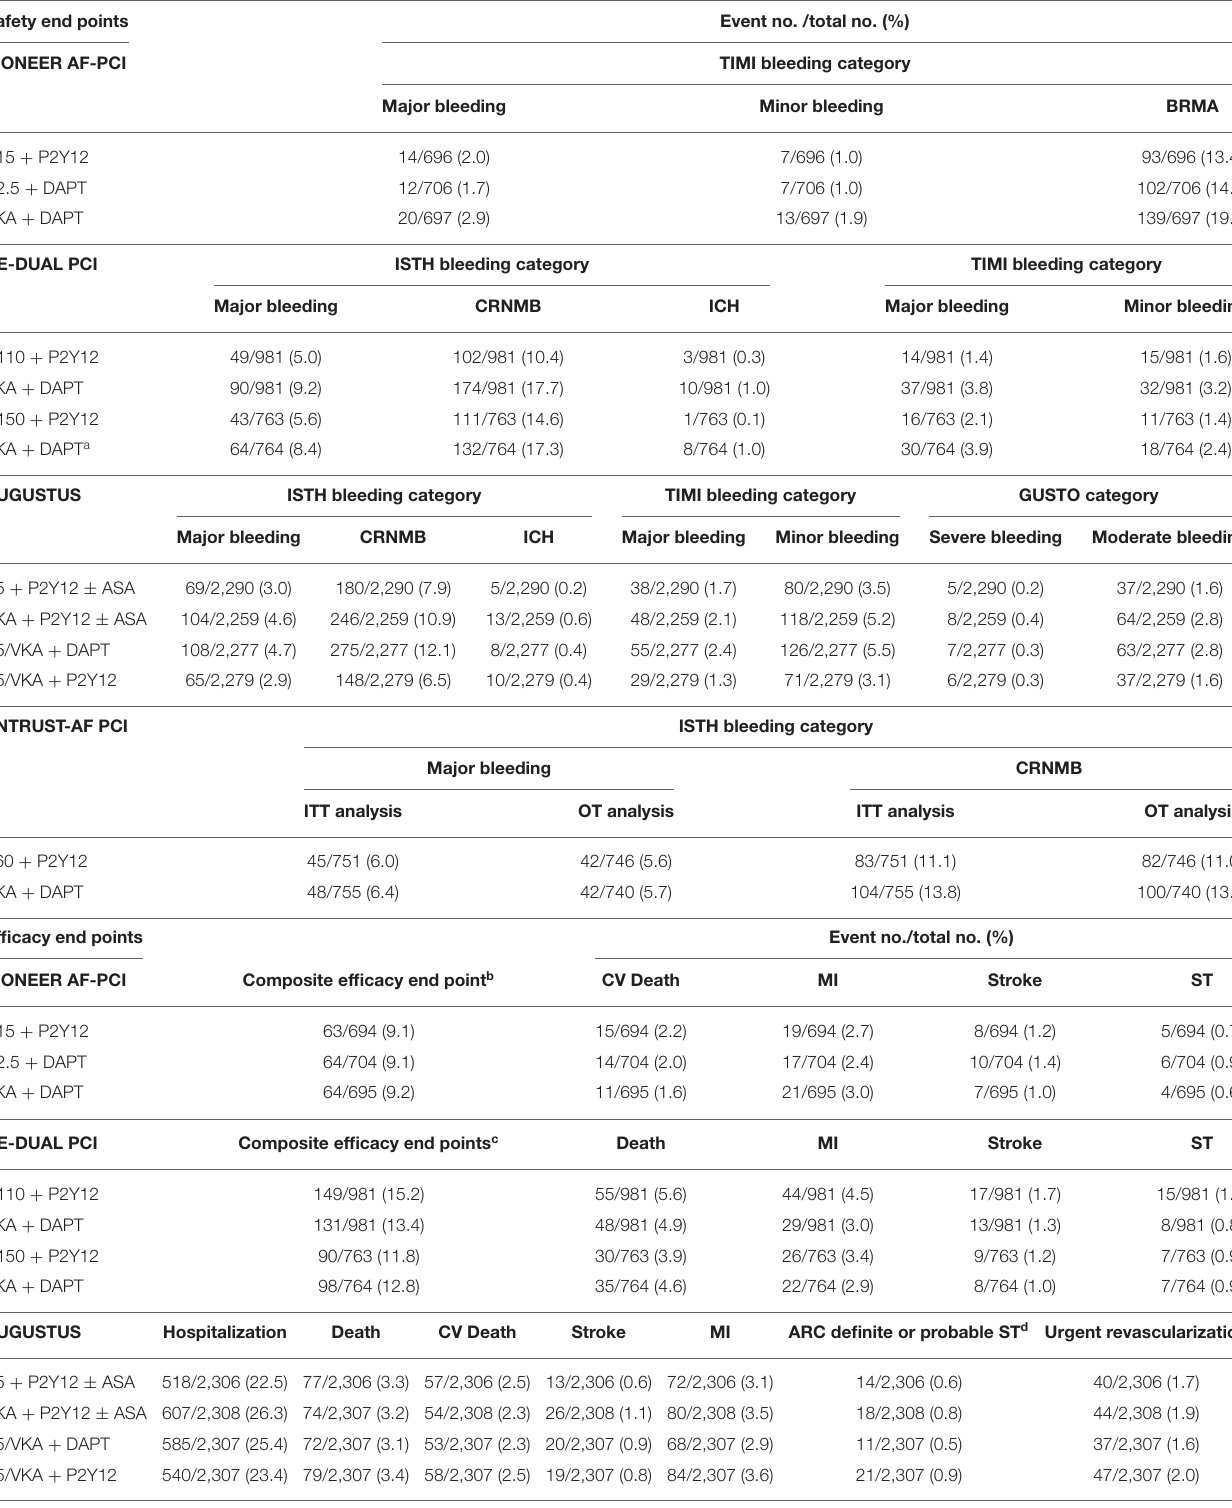
TABLE 1 | Clinical end point presentations with NOAC-based antithrombotic therapy regimens for AF patients undergoing PCI or with ACS: PIONEER AF-PCI, RE-DUAL PCI, AUGUSTUS, and ENTRUST-AF PCI trials. Safety end